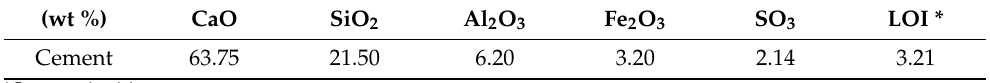
Table 1. Chemical composition of OPC (ordinary Portland cement) used in this study.